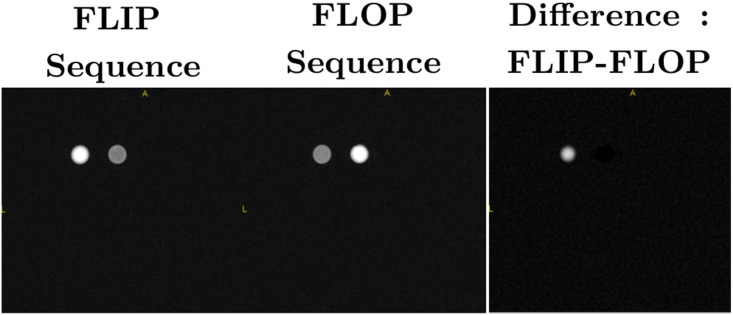
Flip-flop MRI sequence acquisition.From left to right: flip sequence, flop sequence and substracted image (flip − flop). Experimental conditions: flowing water in a 3mm inner diameter silicone tube, vmean = 120μm/s, TR = T1/2 = 1.23s, TE = 15ms, FOVREAD = 20mm, FOVPHASE = 20mm, NREAD = NPHASE = 128, Thk = 1mm, 4 Slices and Tacq = 2 × 2min38.